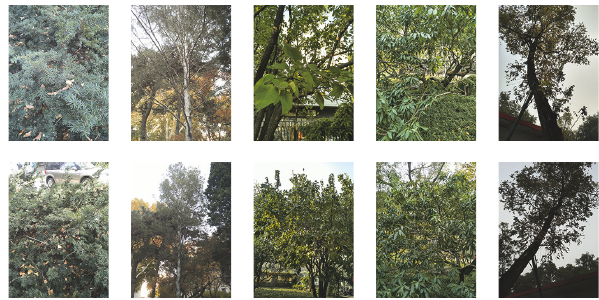
Figure 6: Each column shows one observation-centered sample from the BJFU100